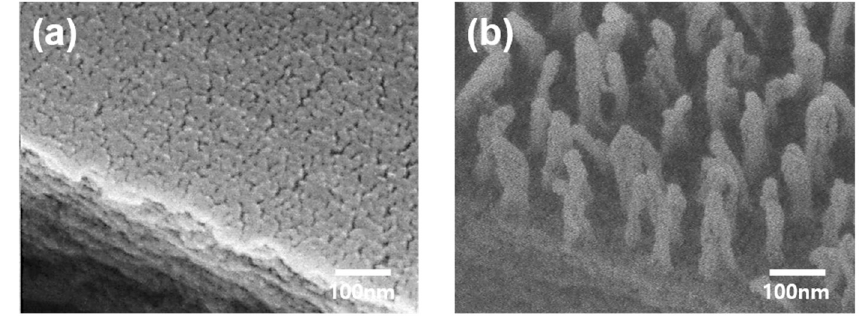
Figure 3. FE-SEM 45 ° -tilted images of ( a ) bare PET and ( b ) CF 4 -RIE PET.